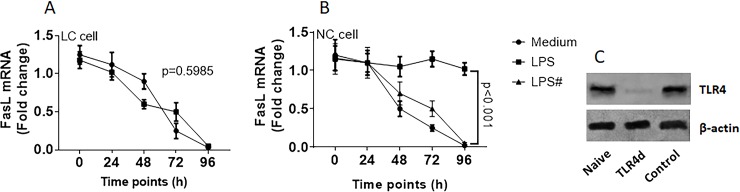
FasL mRNA decays spontaneously.NC cells and LC cells were exposed to cisplatin in the culture for 48 h to increase the expression of FasL, washed with fresh medium, and then cultured in the presence or absence of LPS (100 ng/ml). The cells were harvested at indicated timepoints and analyzed by RT-qPCR. The curves show the levels of FasL mRNA in LC cells (A) and NC cells (B). C, results of TLR4 RNAi. TLR4d: TLR4-deficient NC cells. #, TLRd NC cells exposed to LPS in the culture. Data are presented as mean ± SEM and represent 6 independent experiments.